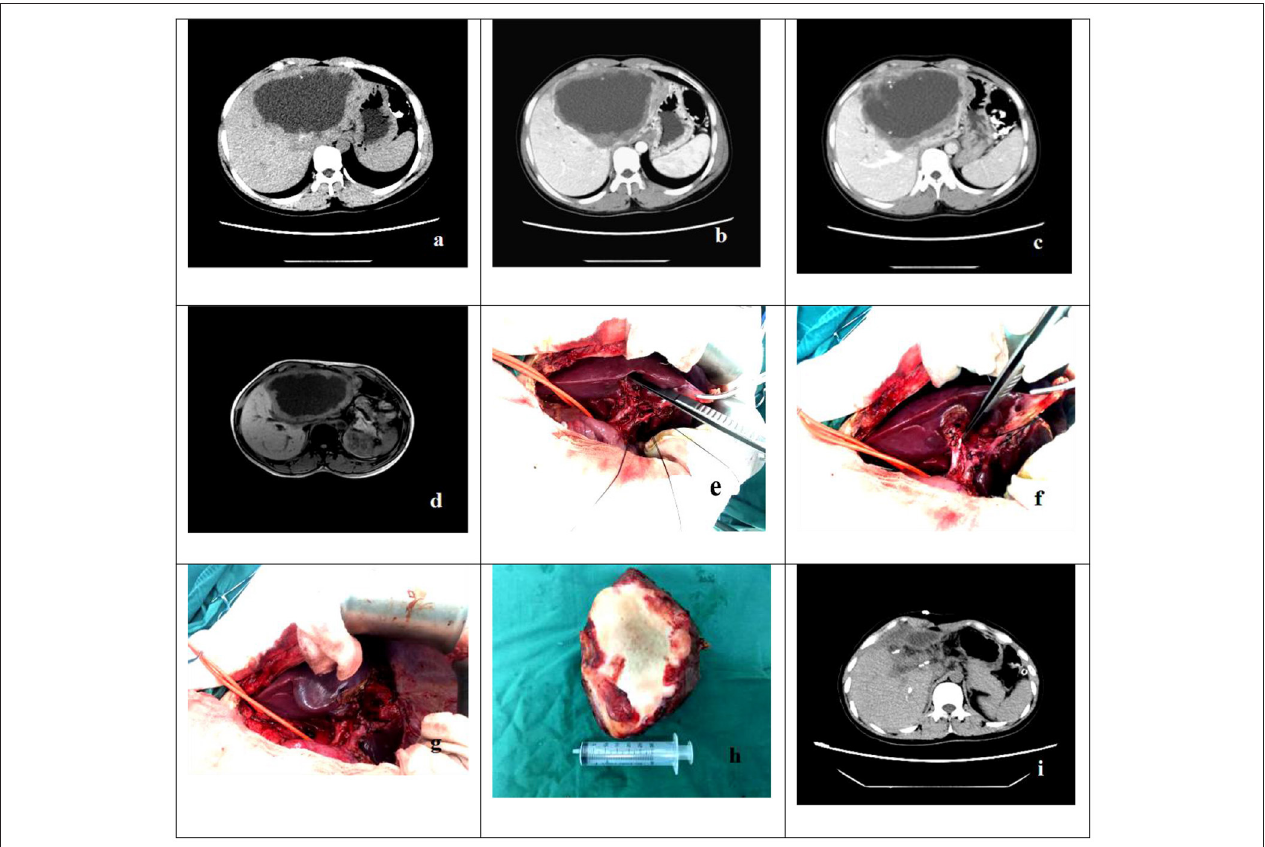
FIGURE 1 | The case is a 32-year-old female patient who was hospitalized due to the chief complaint of “intermittent right upper abdominal distension, pain and discomfort for more than 4 years”. (a–d) Preoperative abdominal CT of patients showed that there was a lesions of echinococcosis in the liver with the size of about 12.0 × 7.0cm in S2-4 segments. (e–h) The intraoperative anatomy of the first hepatic portal and pathologic specimens. (i) Abdominal CT showed that there was residual liver compensatory and hyperplasia, but there was no recurrence of